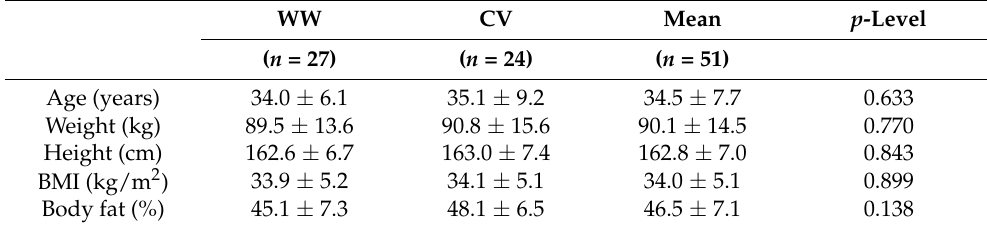
Table 1. Baseline